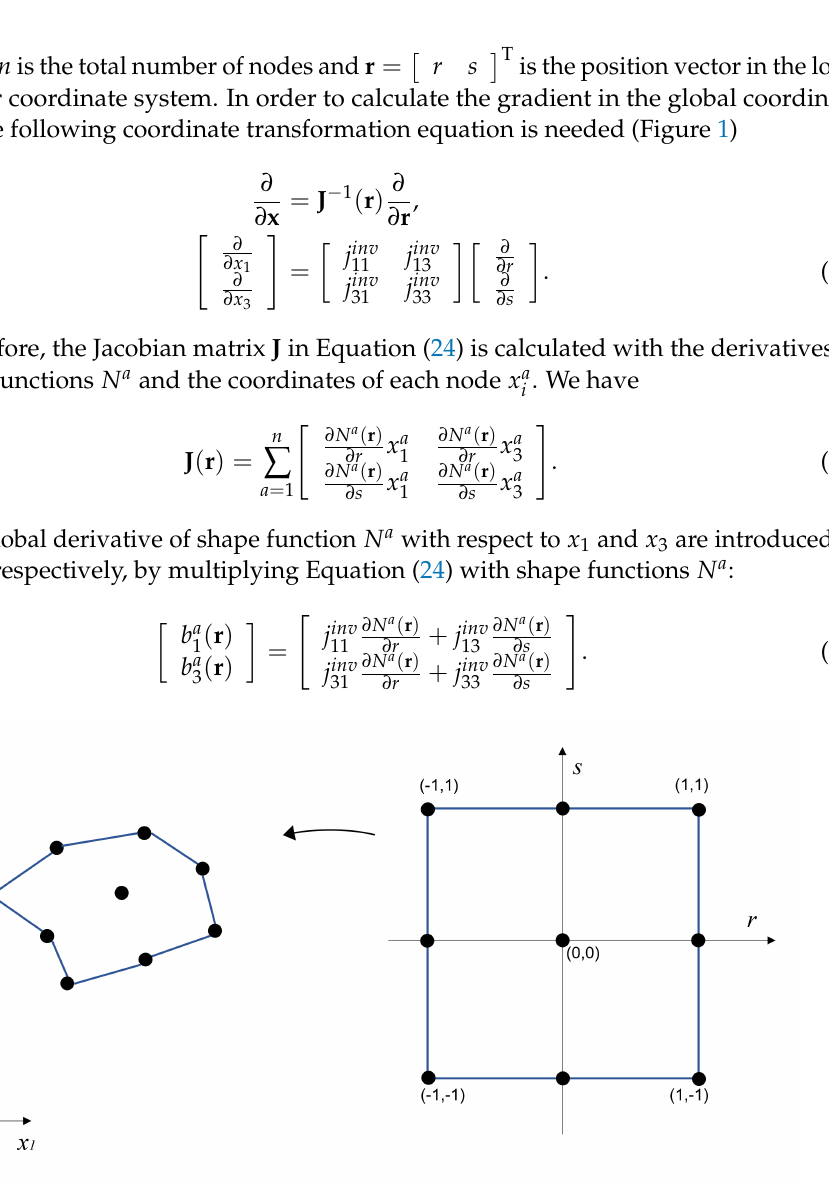
Figure 1. General two-dimensional coordinate transformation of a quadrilateral element from local curvilinear coordinates to a global Cartesian coordinate